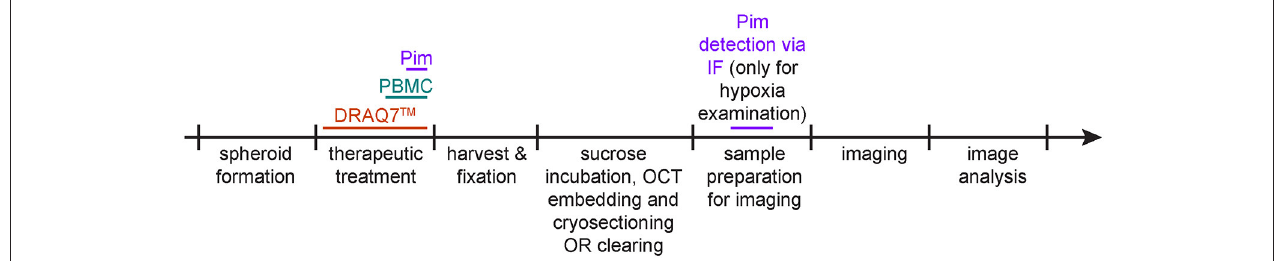
FIGURE 2 | Protocol schematic. Spheroid treatment timeline for detection of hypoxia via pimonidazole staining (purple), of cell death via DRAQ7 TM (orange) and of infiltrating PBMCs